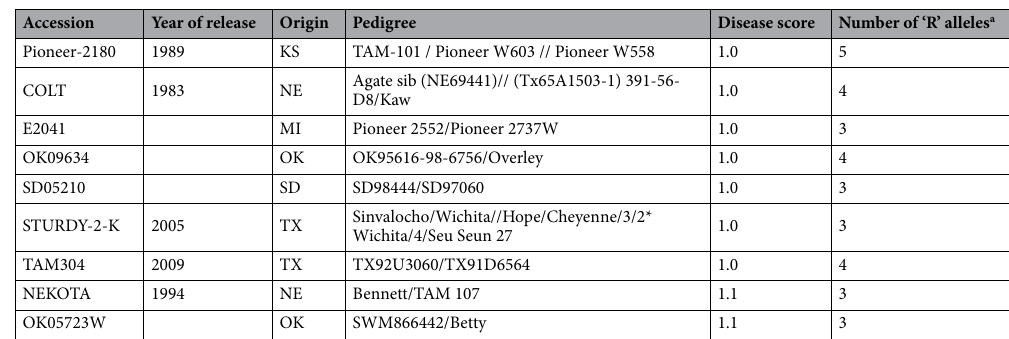
Table 1. Hard winter wheat association mapping panel (HWWAMP) accessions showing a high level of resistance against SNB, along with their mean disease score across three experiments. a The number of resistance-associated alleles at seven of the MTAs identified in this